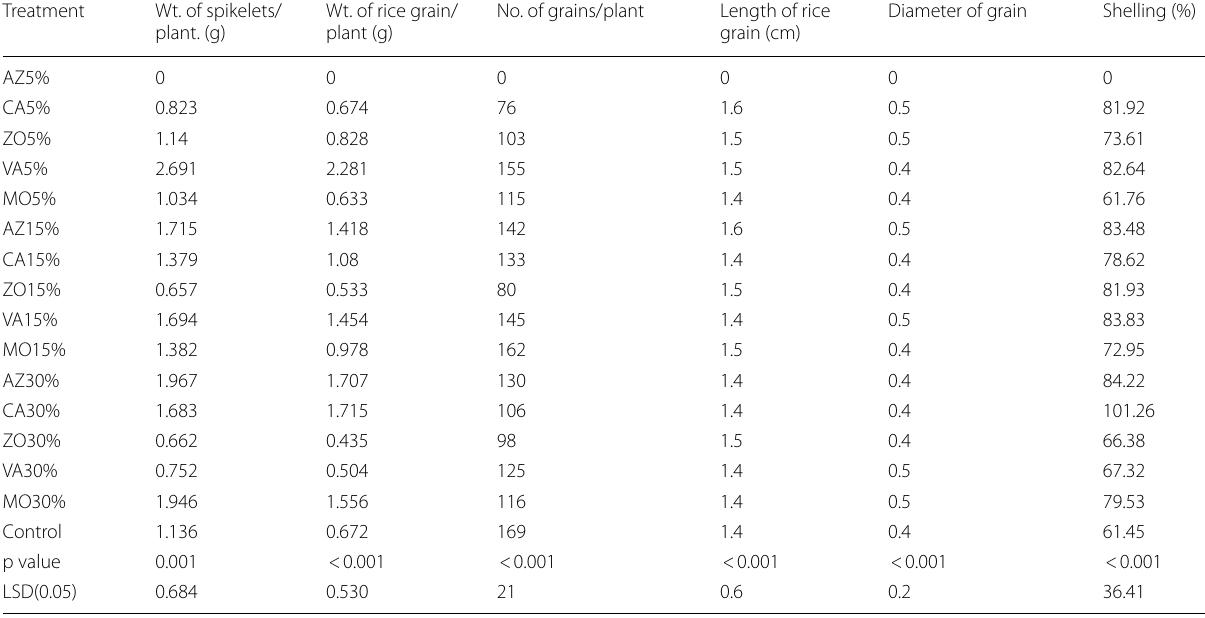
Table 5 The effects of nanoparticles on the yield of rice plants at 12 weeks after sowing (8 weeks after application of nanoparticles) in non-ferruginous soil Treatment Wt. of spikelets/ plant. (g)